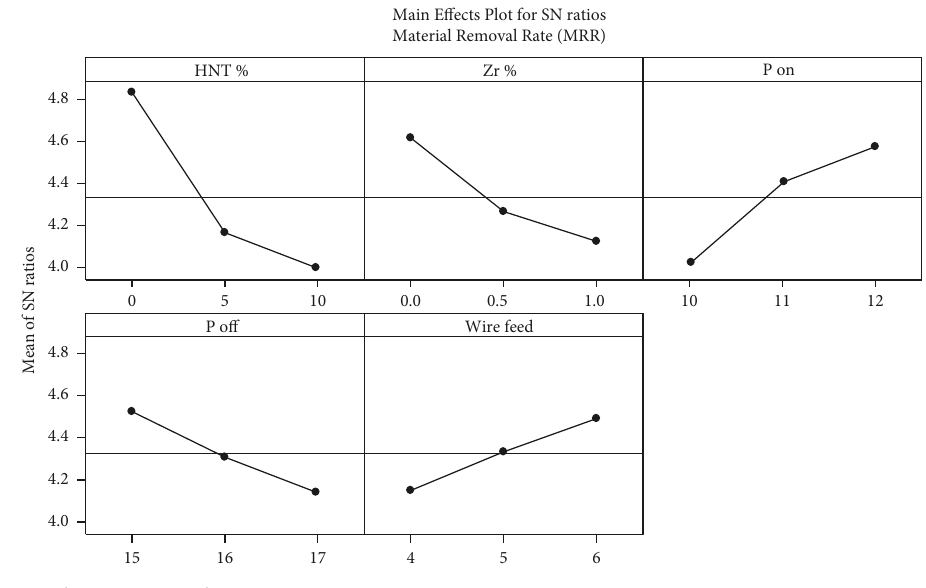
Figure 5: Result of input process parameters on MRR.